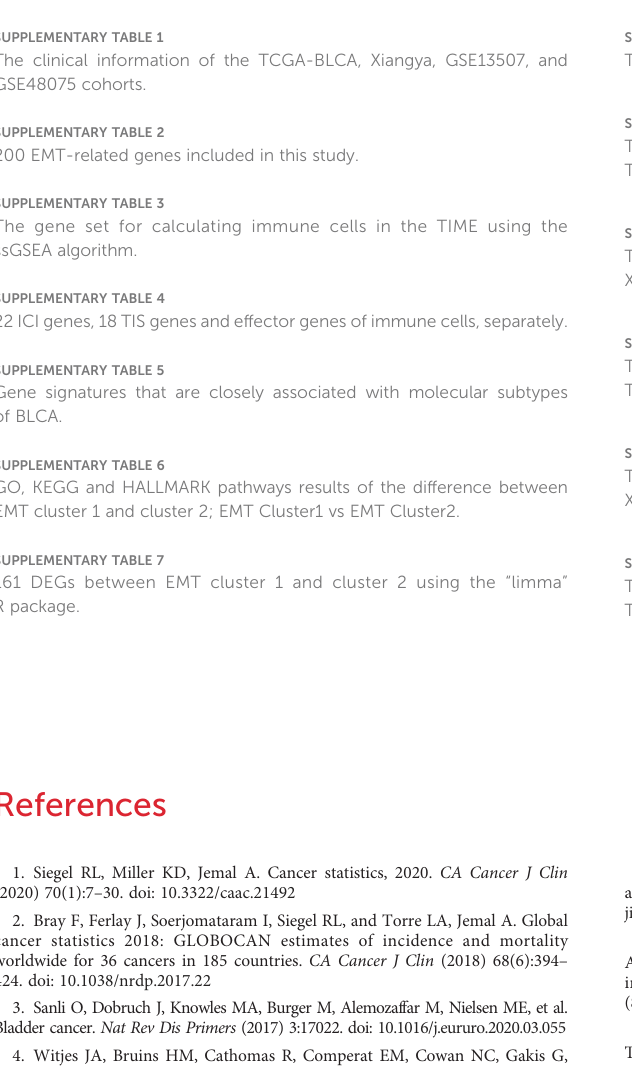
SUPPLEMENTARY TABLE 8 The univariate prognostic values of the 70 EMT-related genes. SUPPLEMENTARY TABLE 9 The association between EMT risk score and cancer immunity cycles in TCGA-BLCA cohort.